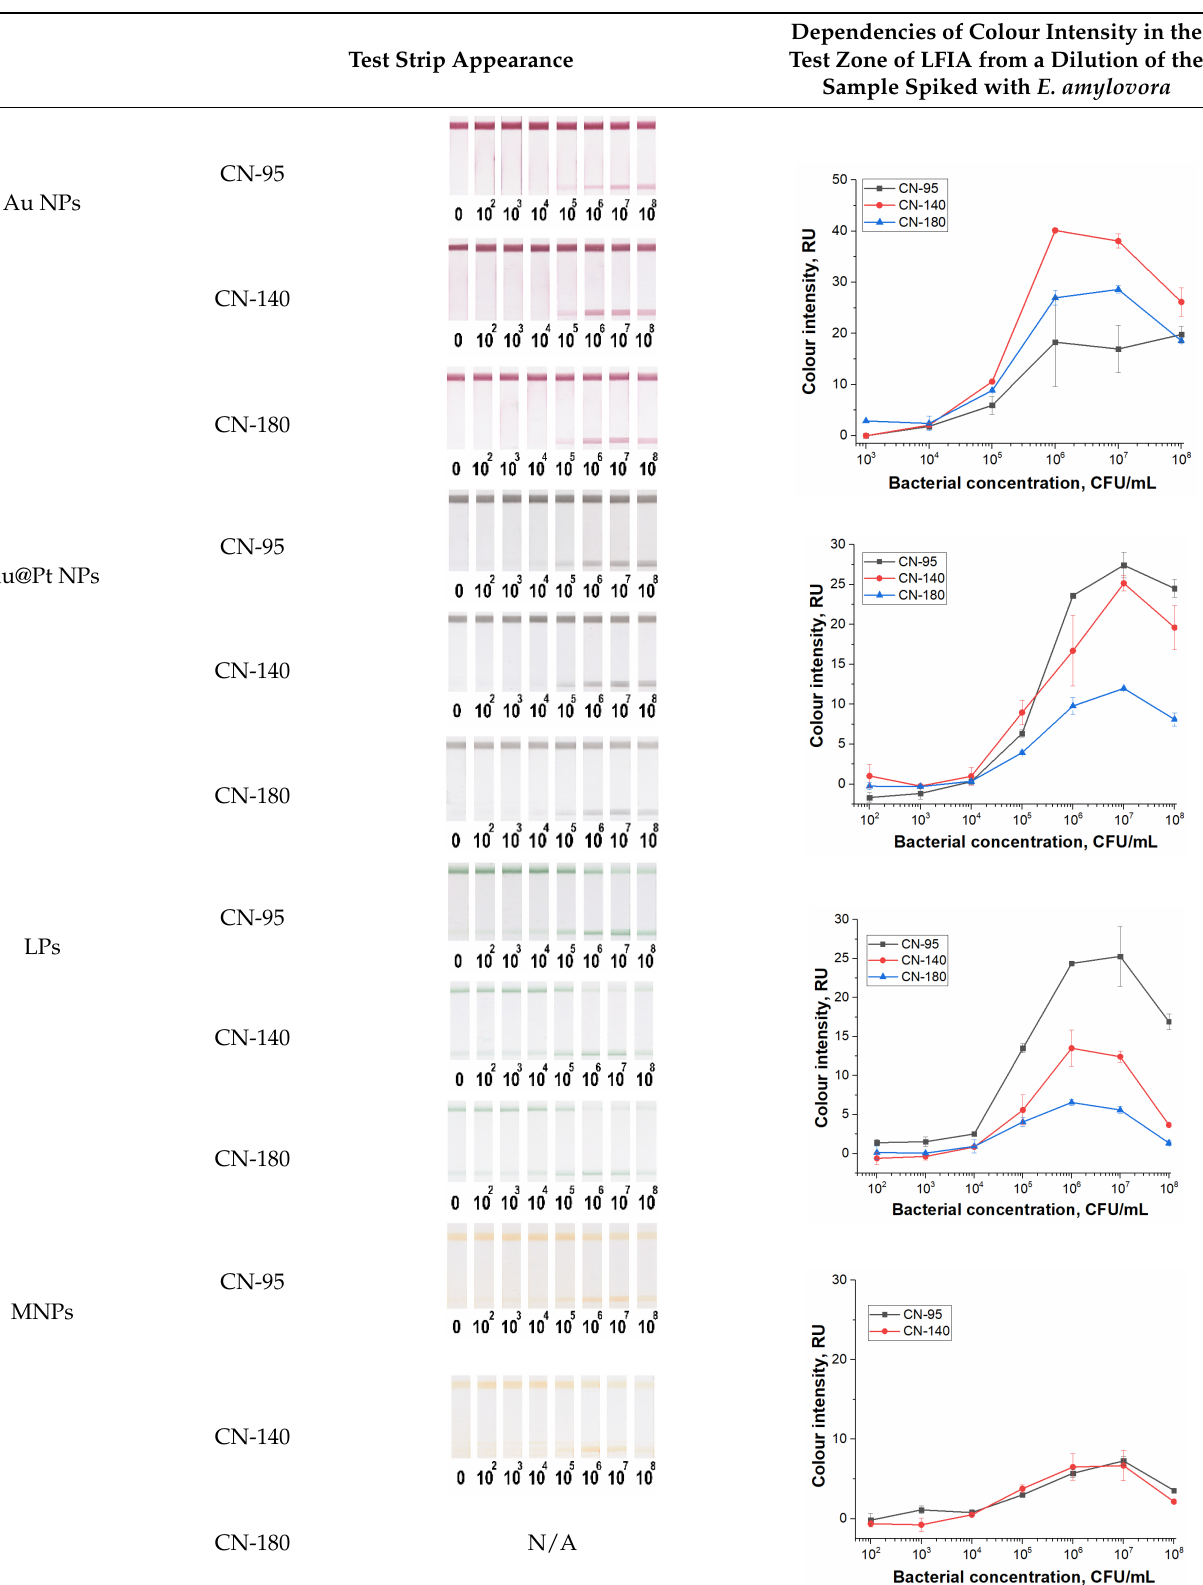
Table 1. Comparison of test strips based on different nitrocellulose membranes and different nanoparticle